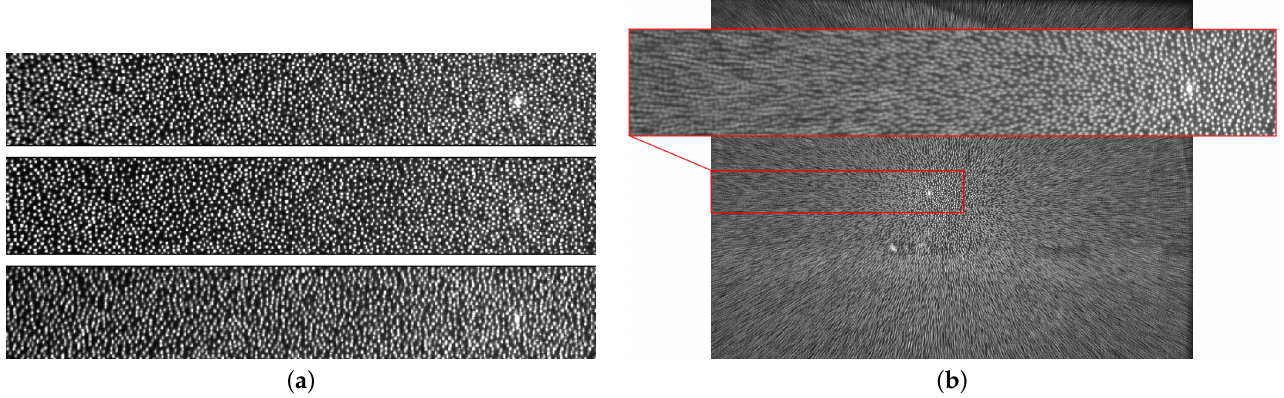
Figure 2. ( a ) From top to bottom, part of the IR images obtained at − 2 ◦ C, 28 ◦ C, and 58 ◦ C. The brightest point in the image indicates the center of the pattern. ( b ) Image corresponding to the mean of the IR images obtained at all evaluated